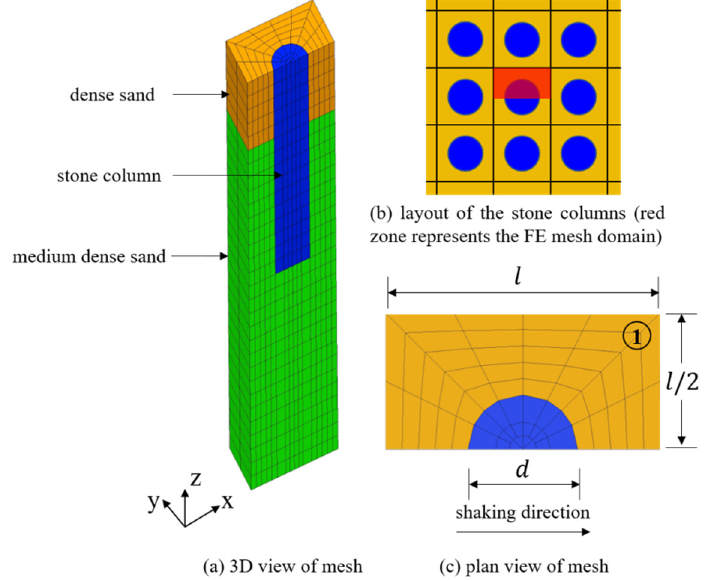
Figure 1. Layout of stone columns composite foundation and FE model.